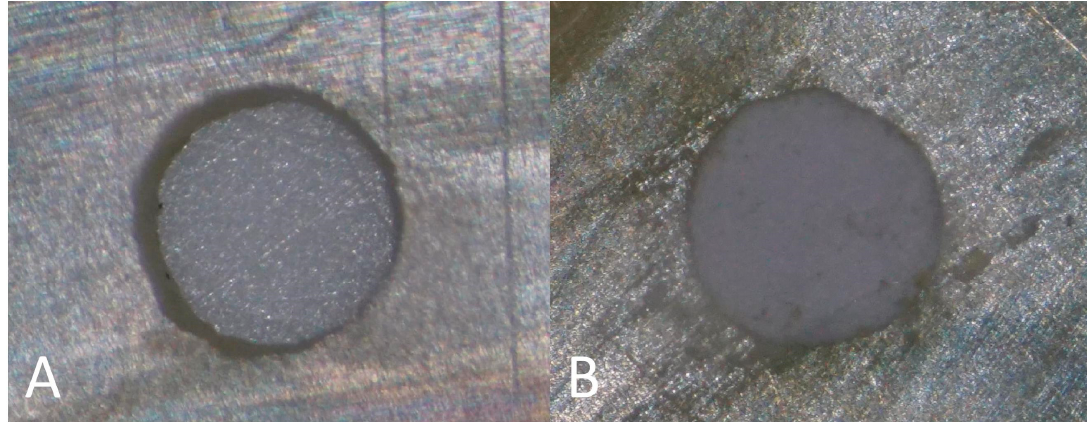
Figure 2. Images of the root slice with the prepared root canal before ( A ) and after ( B ) root canal obturation with BioRoot RCS.